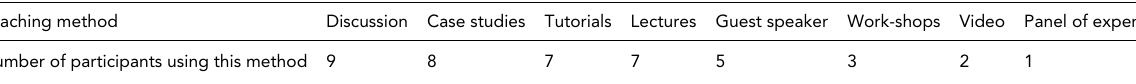
Teaching Methods used to Deliver Indigenous Content Across Four Years of an Occupational Therapy Curriculum Teaching